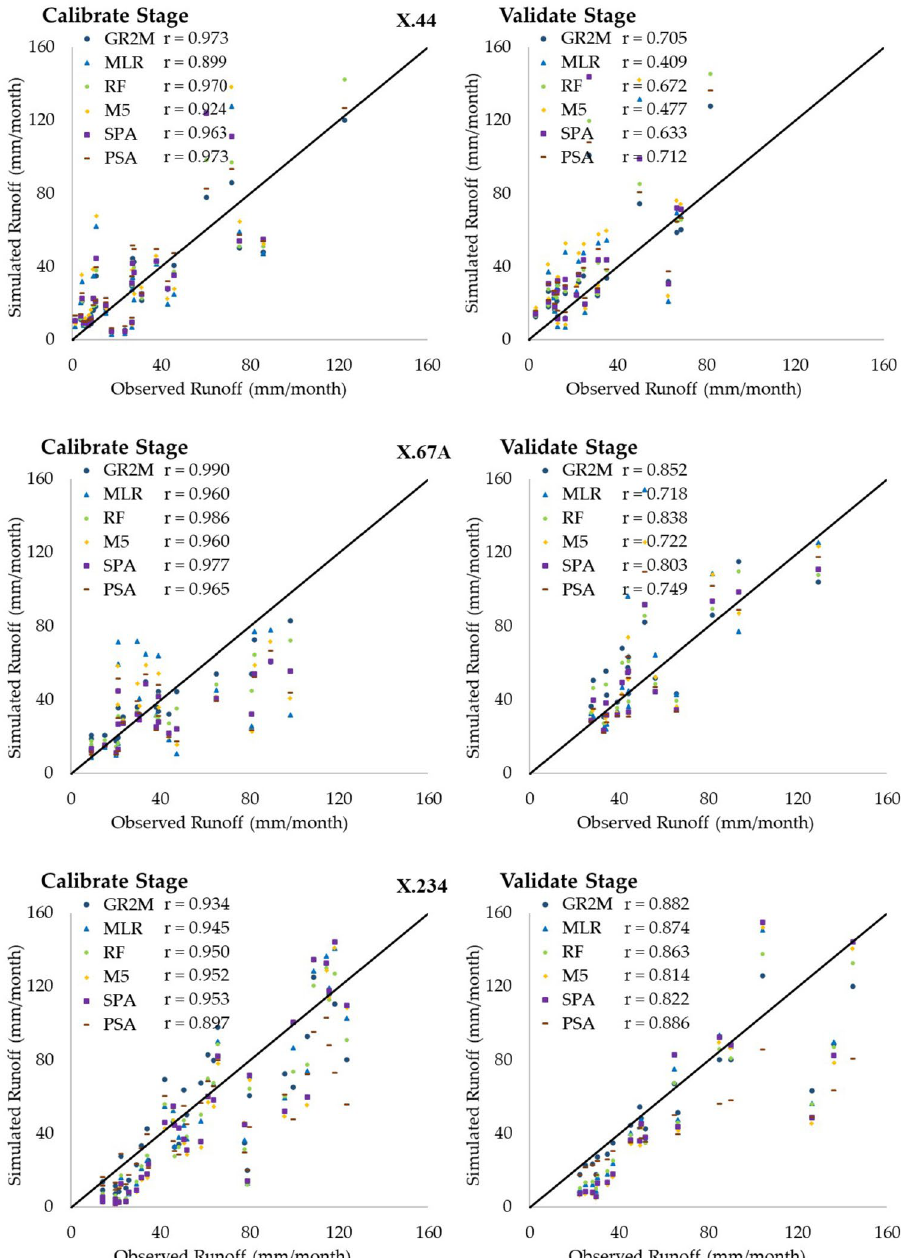
Figure 8. The relationship between the observed runoff and simulated runoff obtained from six methods in X.44, X.67, and